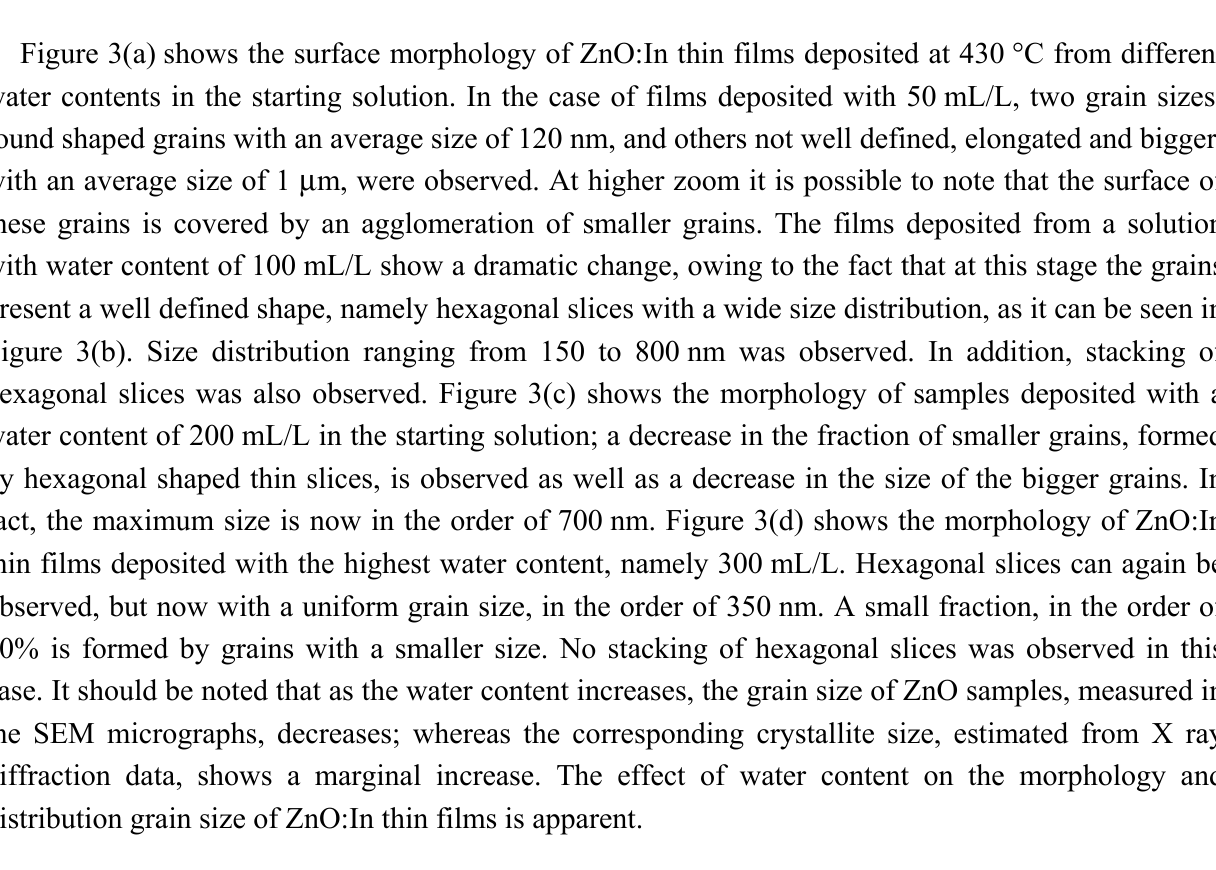
Figure 3. SEM micrographs of ZnO:In thin films deposited at 430 °C from starting solutions with different water contents: ( a ) 50 mL/L, ( b ) 100 mL/L, ( c ) 200 mL/L, and ( d ) 300